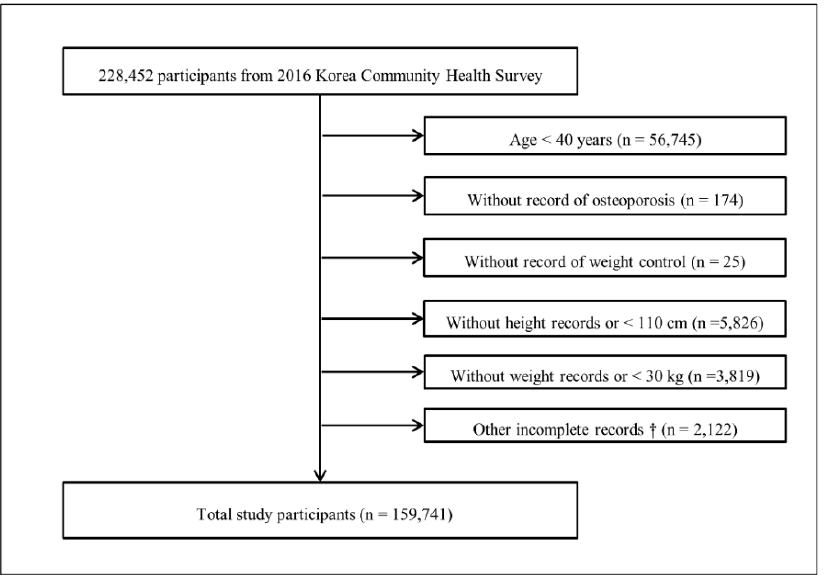
Figure 1. A schematic illustration of the participant selection process used in the present study. Of a total of 228,452 participants, 159,741 participants were selected after exclusion.